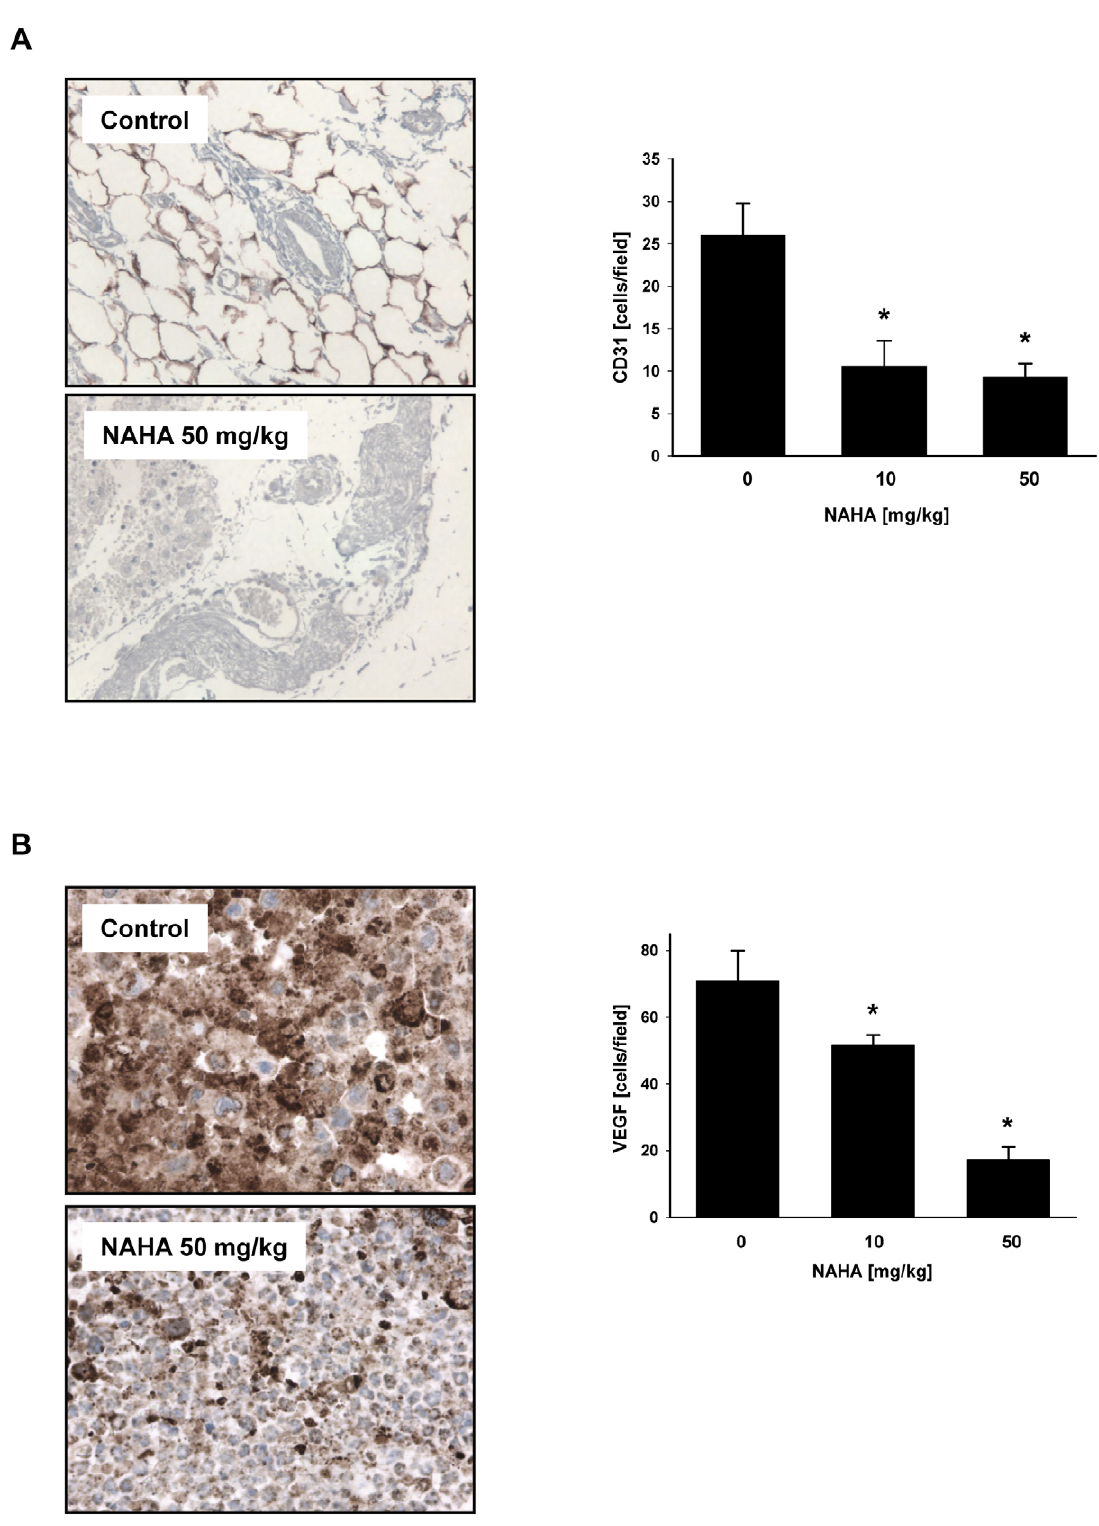
Figure 5. Expression of CD31 and VEGF in tumors. The expression of (A) CD31, and (B) VEGF were quantified as described in Materials and Methods . Data are mean 6 SD (n=6–10), * significantly different from control (p , 0.05) by ANOVA. doi:10.1371/journal.pone.0034283.g005 24-well plate. HAECs were incubated with NAHA (0–50 m M) for SingleQuots kit. HAECs differentiated into capillary-like struc- 16 hours in MEBM media supplemented with EGM H -2 MV tures within 16 hours of incubation at 37 u C. After 16 hours of